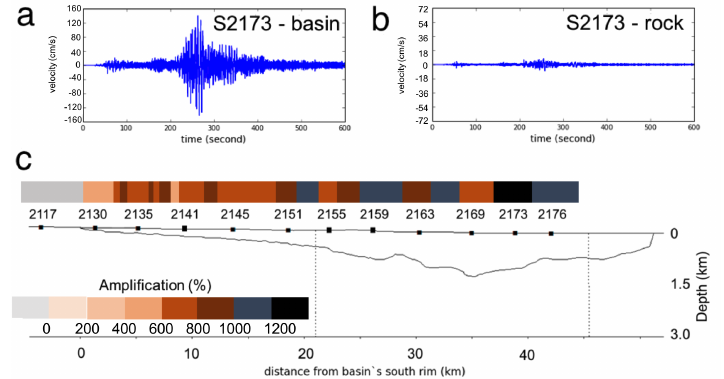
Figure 14. Similar to Figure 13 a–c , these figures depicting seismograms at (a) basin and (c) rock sites (S2173) and (c) PGV amplification for the megathrust earthquake